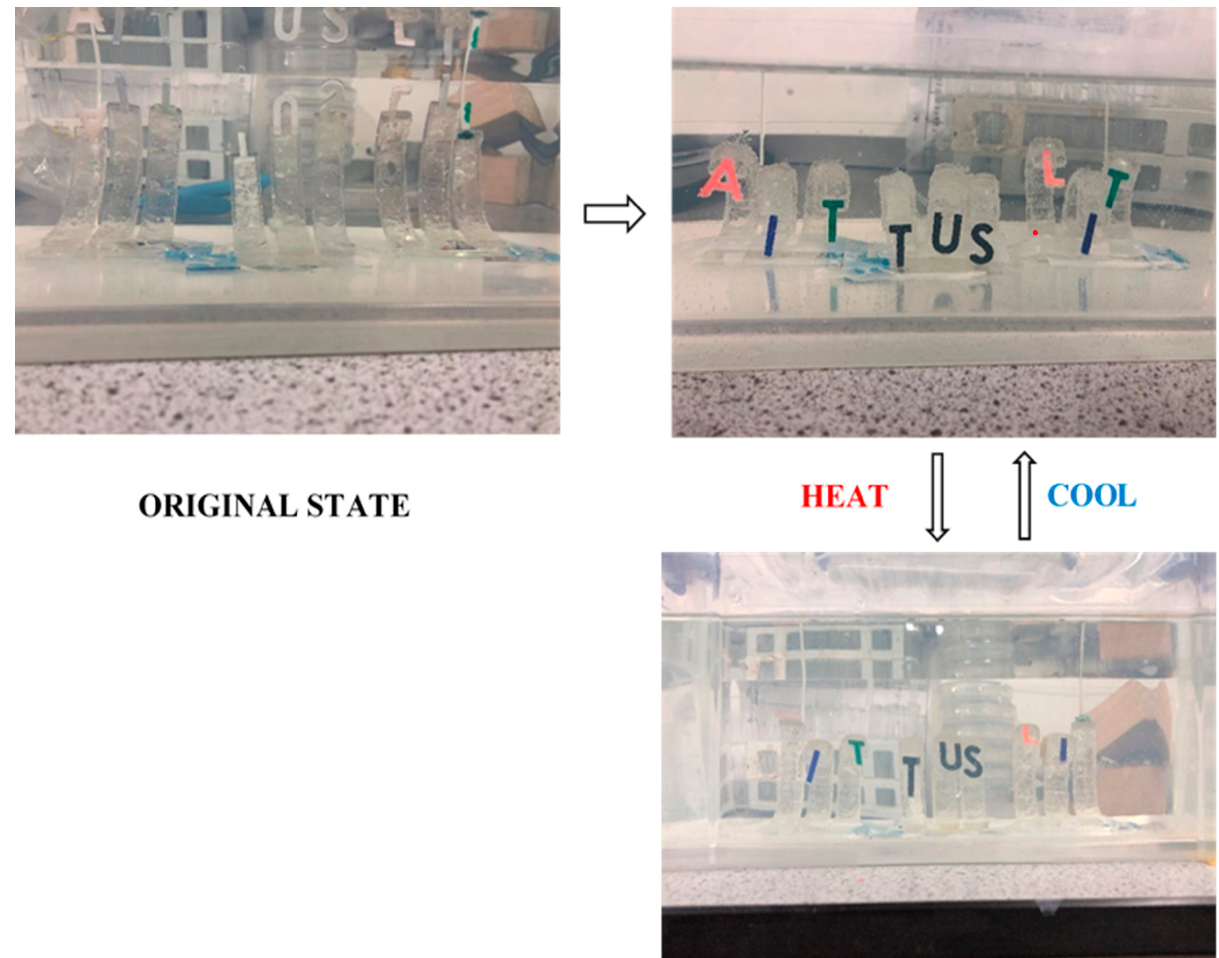
Figure 11. The TUS automatic displayers are achieved by using ‘b’ type bilayer strips.